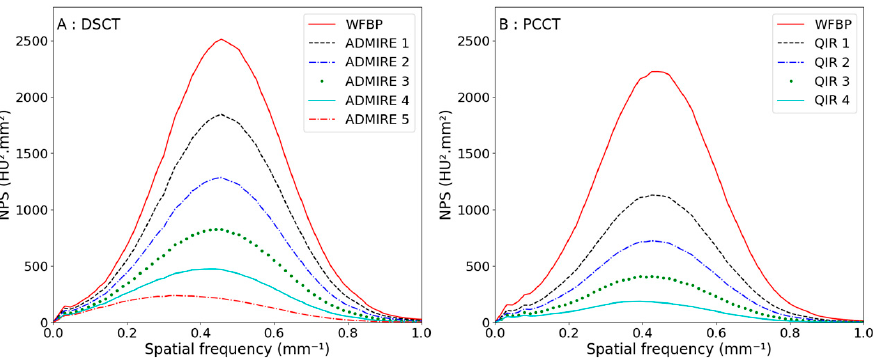
Figure 2. Noise power spectra curves using polyenergetic reconstruction with a CTDI vol of 10 mGy when increasing the iteration level of the reconstruction algorithm for the DSCT ( A ) and the PCCT ( B ).